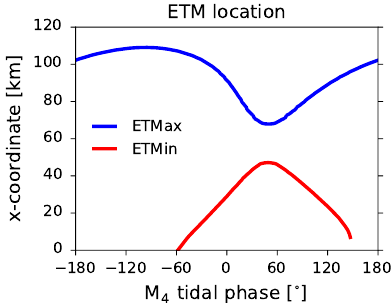
Figure 13. Sensitivity of the location of the ETM to varying exter- nal M 4 tidal phases in the Scheldt Estuary. The blue and red lines indicate a maximum and minimum in the sediment concentration in the model domain